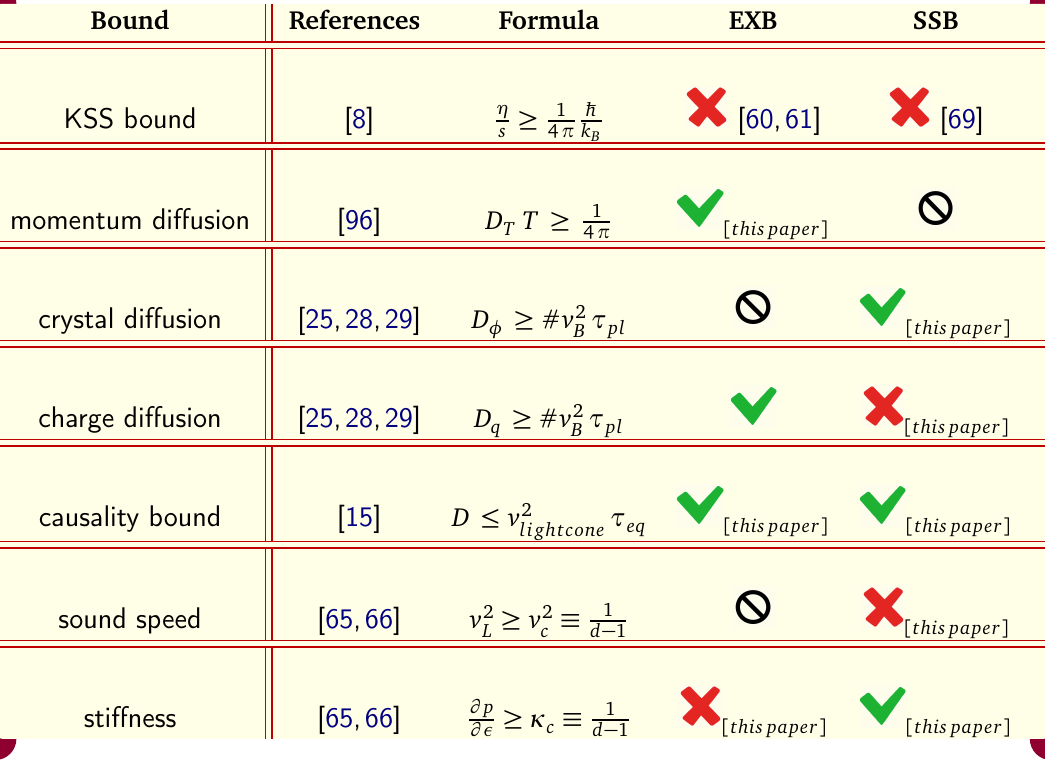
Table 2: A summary of our results. EXB stands for explicit breaking of translations and SSB for spontaneous breaking of translations. The green, red and black symbols indicate respectively the validity, the violation and the inapplicability of the corre- sponding